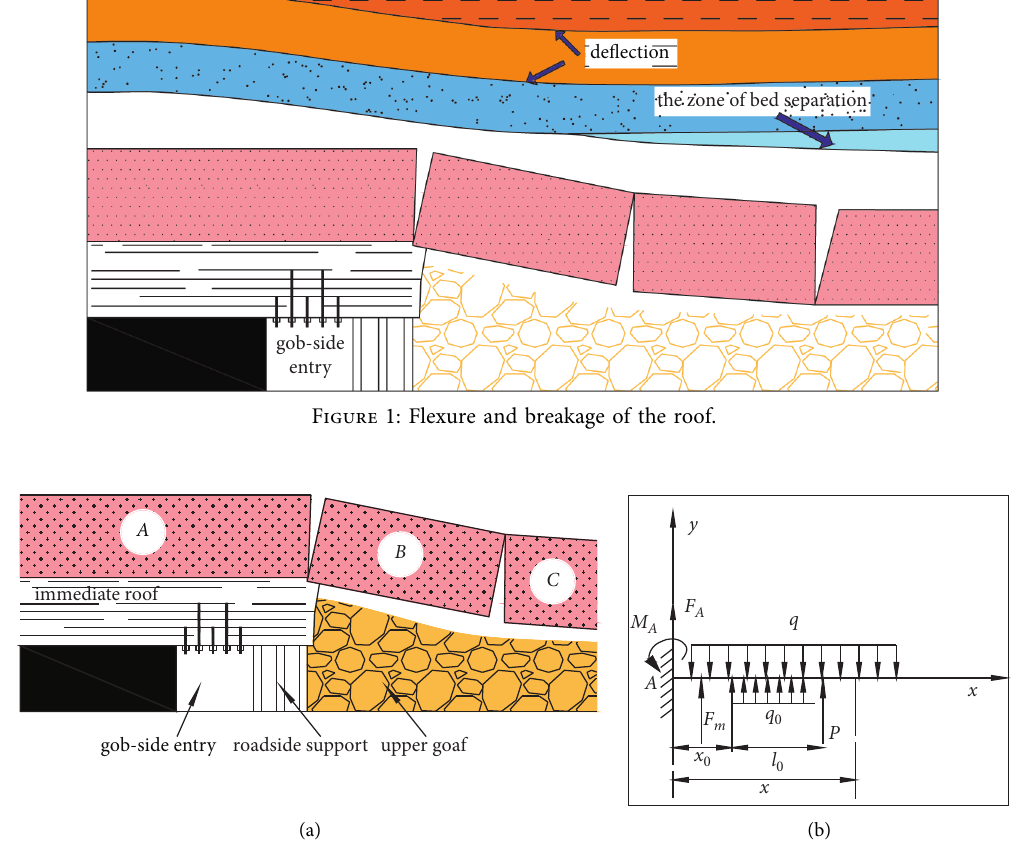
Figure 2: Model and mechanical calculation of the rock-beam breaking structure. (a) Model of top-plate breaking structure. (b) Analysis of cantilever beam